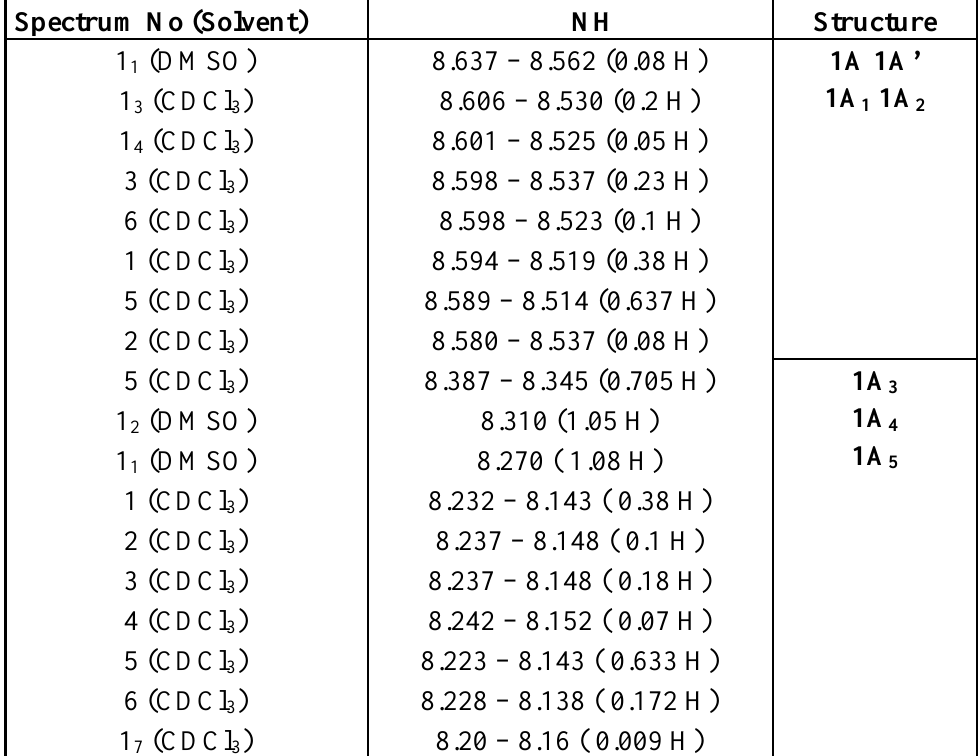
Table 10 . The 1 H-NMR chemical shifts δ [ppm] from TMS of the NH group of tautomer